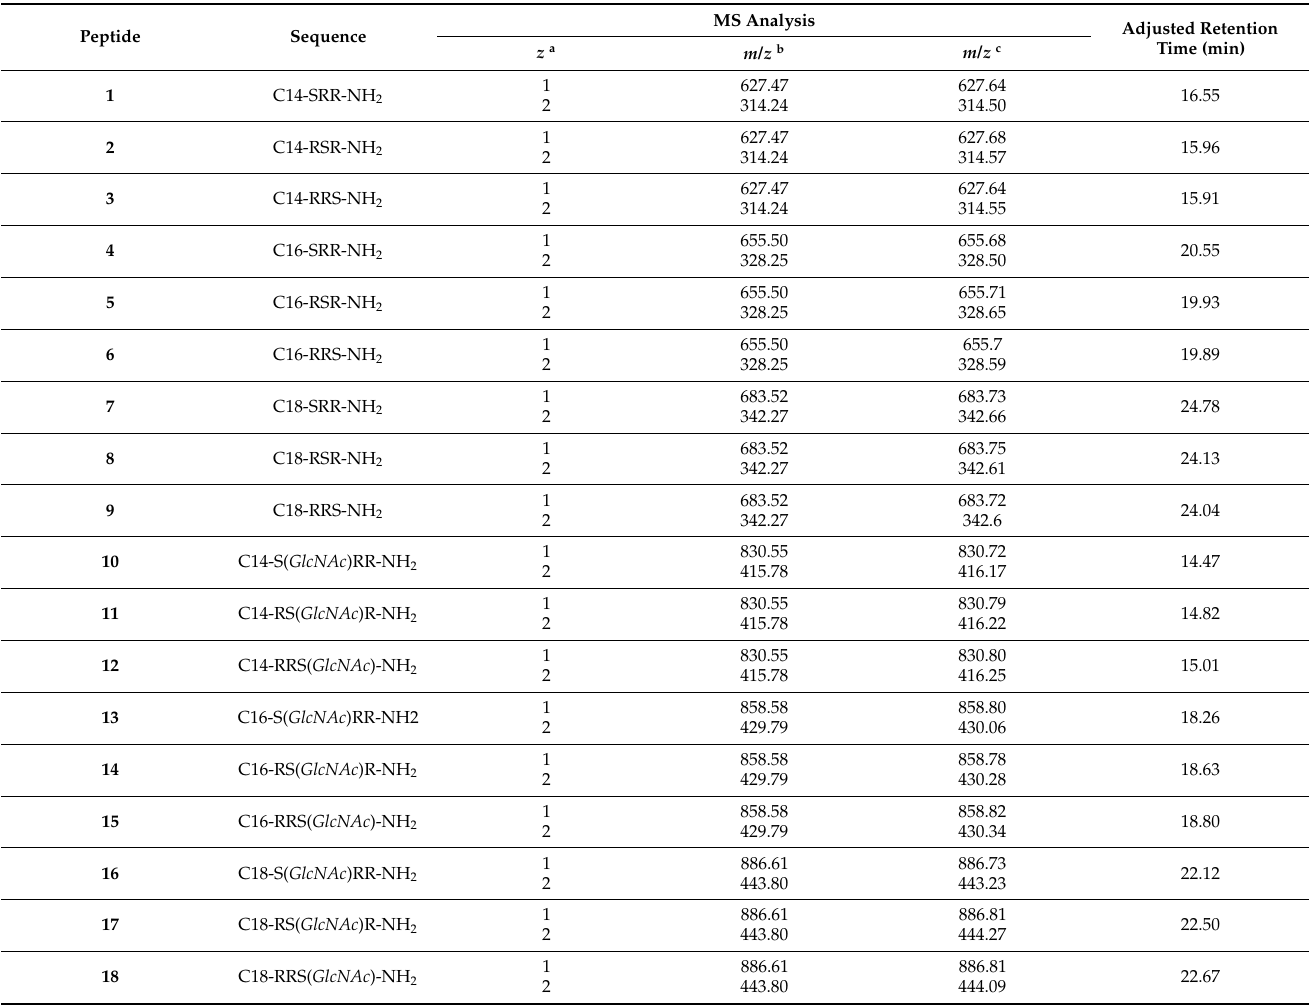
Table 1. Sequences, MS analysis and retention times of lipopeptides 1 – 18